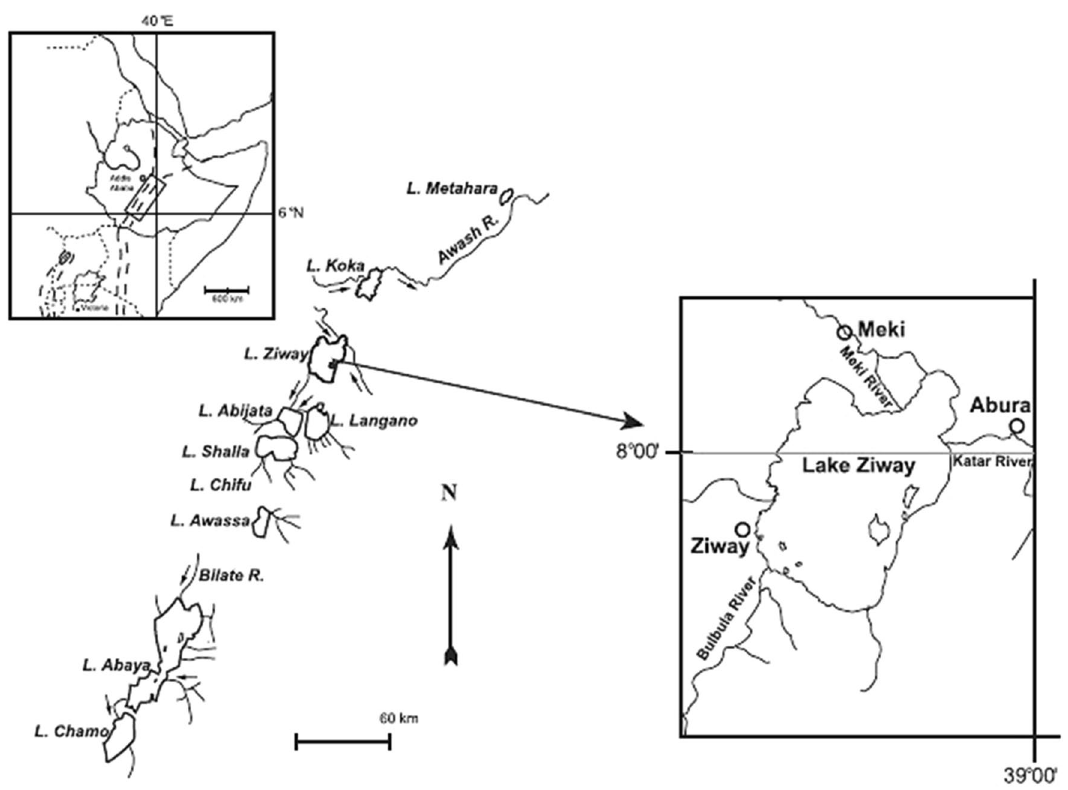
Fig. 1 Map showing Lake Ziway (Adopted and modified from Deribe et al. [16])